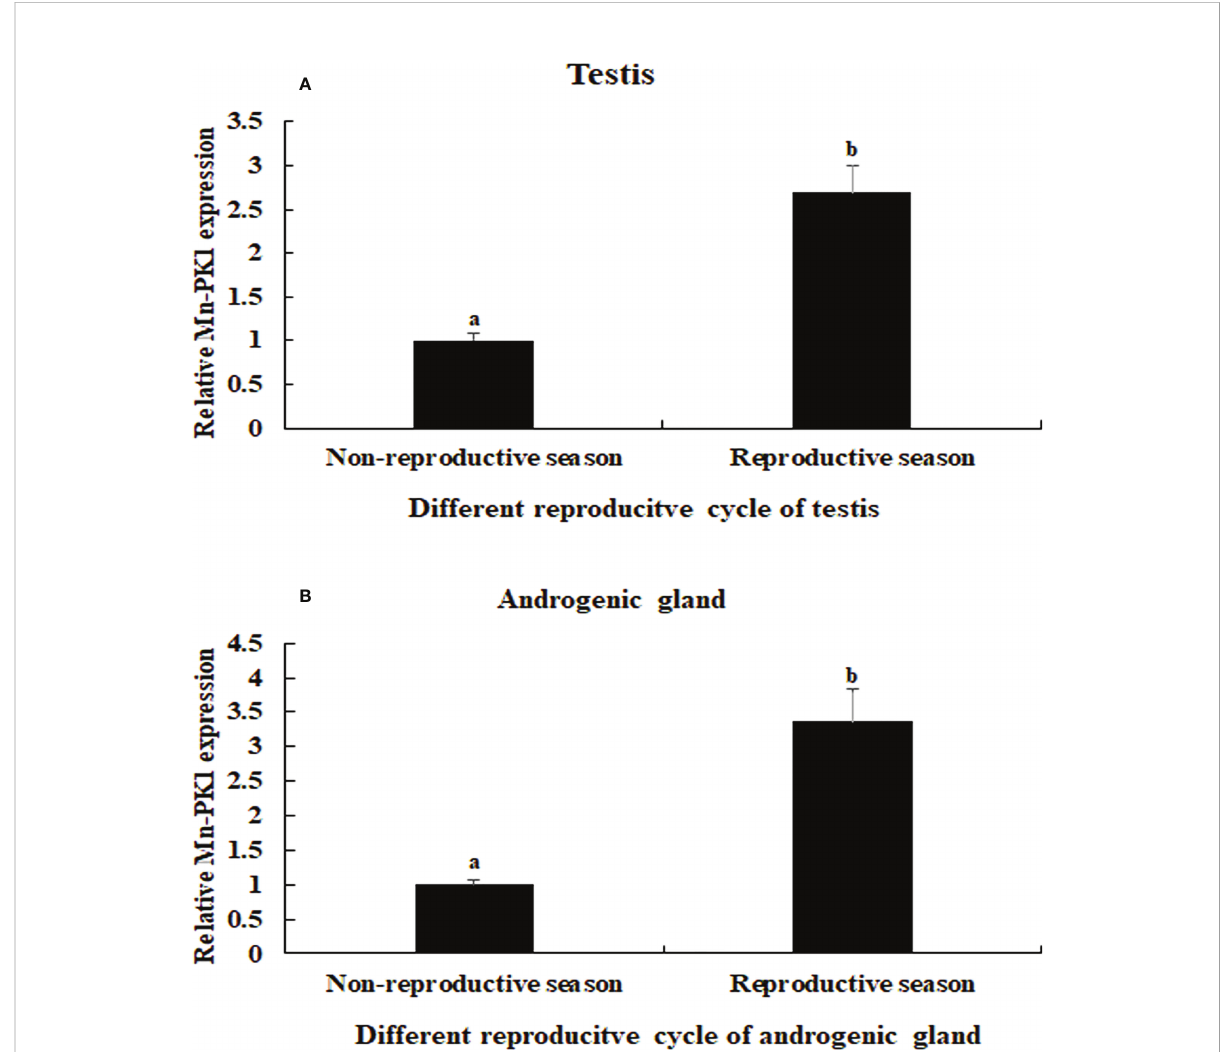
FIGURE 5 Measurement of the Mn-Plk1 expression in the testis and androgenic gland taken from different reproductive season. The amount of Mn-Plk1 mRNA was normalized to the EIF transcript level. Data are shown as mean ± SD (standard deviation ) of tissues from three separate individuals. Lowercases (a, b) on the bars indicate expression differences between different samples (independent sample T-test). (A) Mn-Plk1 expression in the testis taken from different reproductive season. (B) Mn-Plk1 expression in the androgenic gland taken from different reproductive